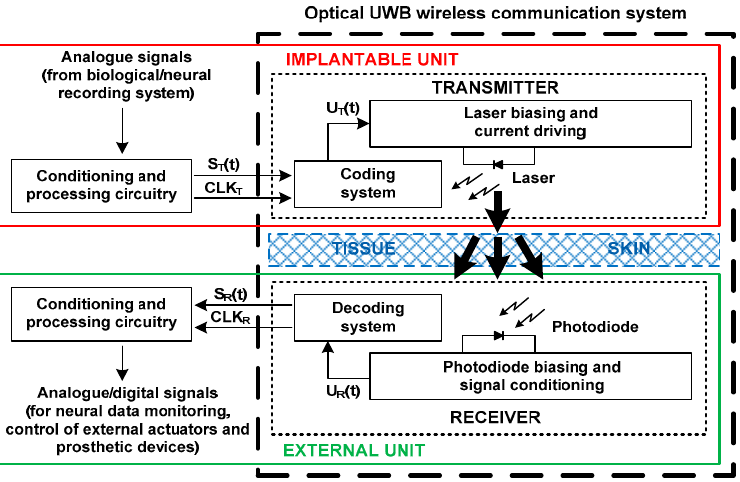
Figure 1. Complete scheme of an optical wireless transcutaneous biotelemetry system: in the dashed box, the architecture implementing the proposed data coding approach based on optical pulsed Ultra-wideband (UWB) modulation